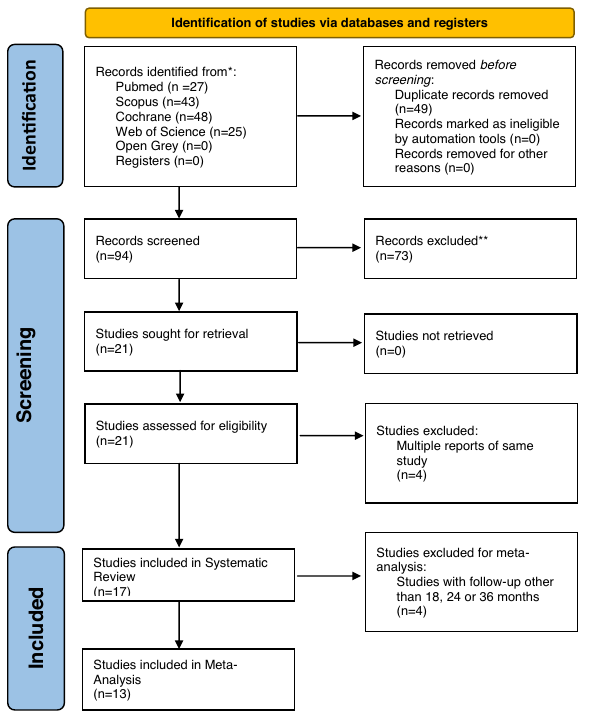
Fig. 1 PRISMA Flowchart. Flowchart of Included Studies according to PRISMA guidelines.